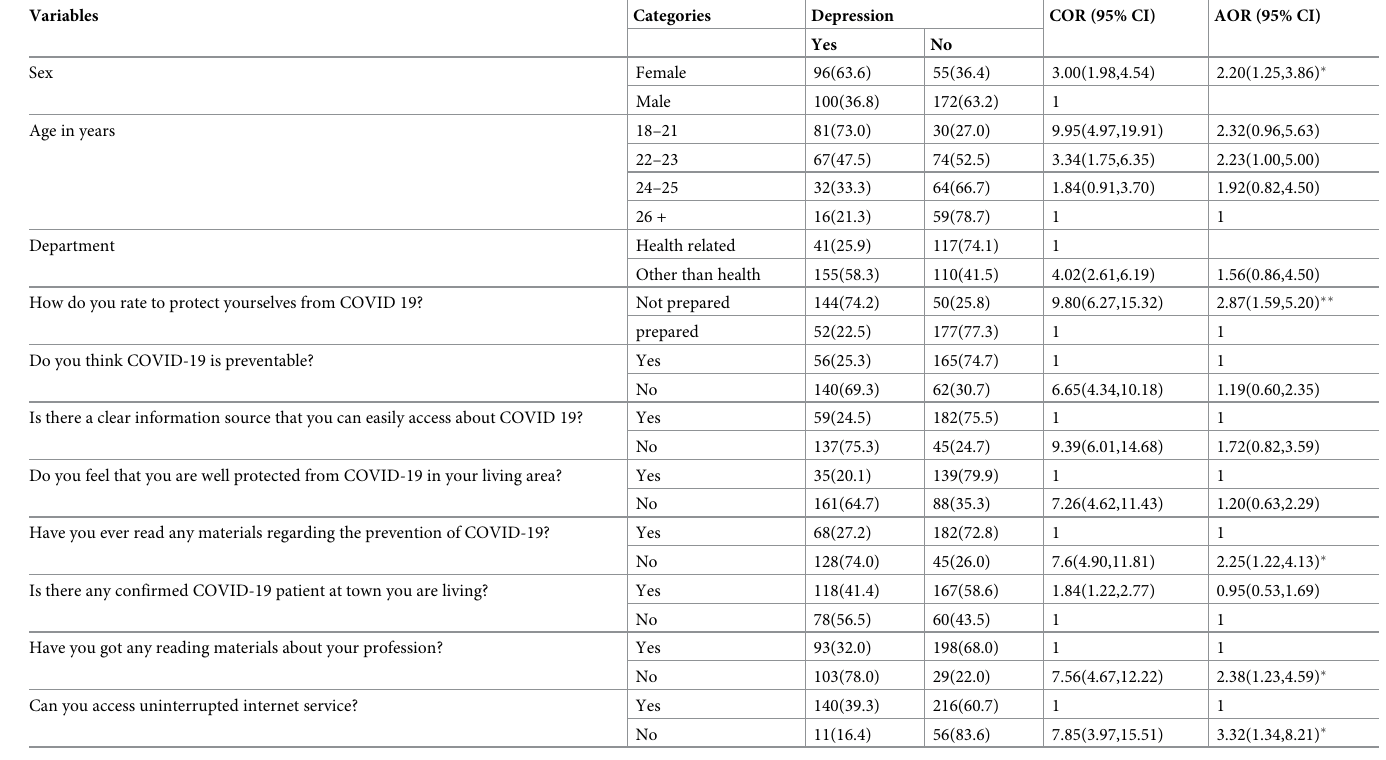
Table 3. Factors associated with depression among Ethiopian University students during the early phase of COVID-19 pandemic, 2020 (N = 423).